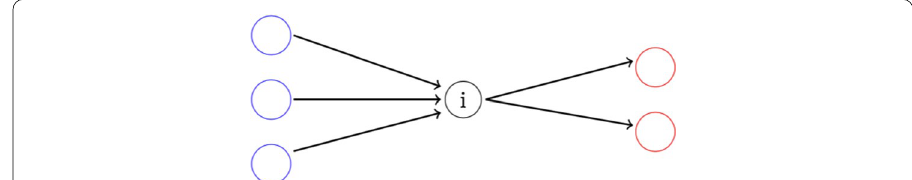
Fig. 8 Example of network. All the in‑neighbors of node i , noted in the model as N in ( i ) , are represented in blue, while its out‑neighbors nodes belonging to N out ( i ) are here represented in